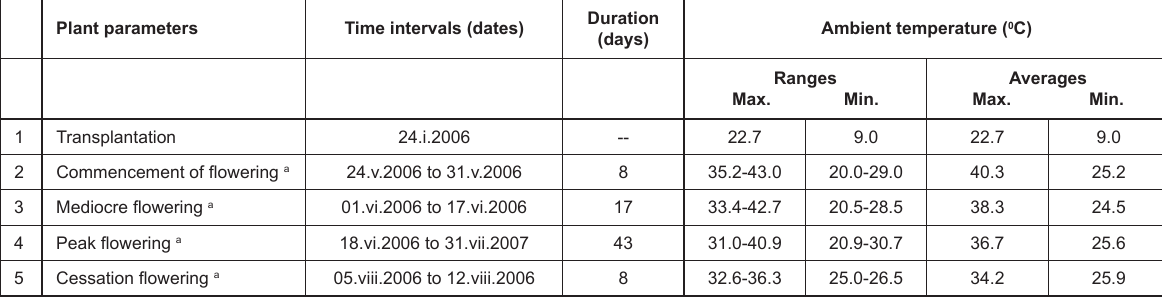
Table 1. Duration of different parameters of Sarpagandha plant in relation to ambient Plant parameters